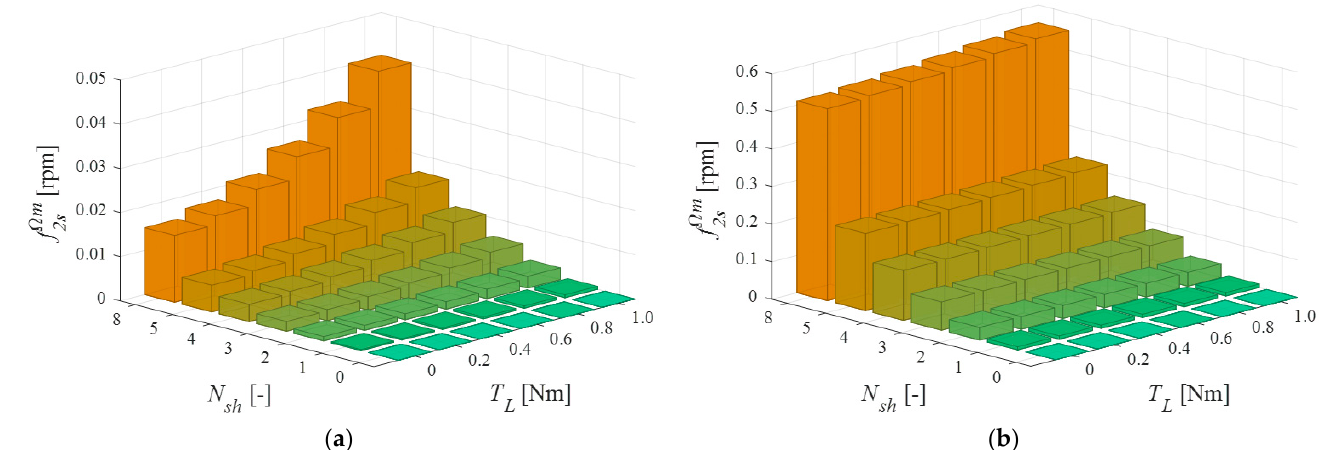
Figure 13. Dependence of the 2nd harmonic of the rotor speed, 2 f s , on the number of shorted turns and the load torque values for f s = 100 Hz: scalar control ( a ), field-oriented control ( b ).